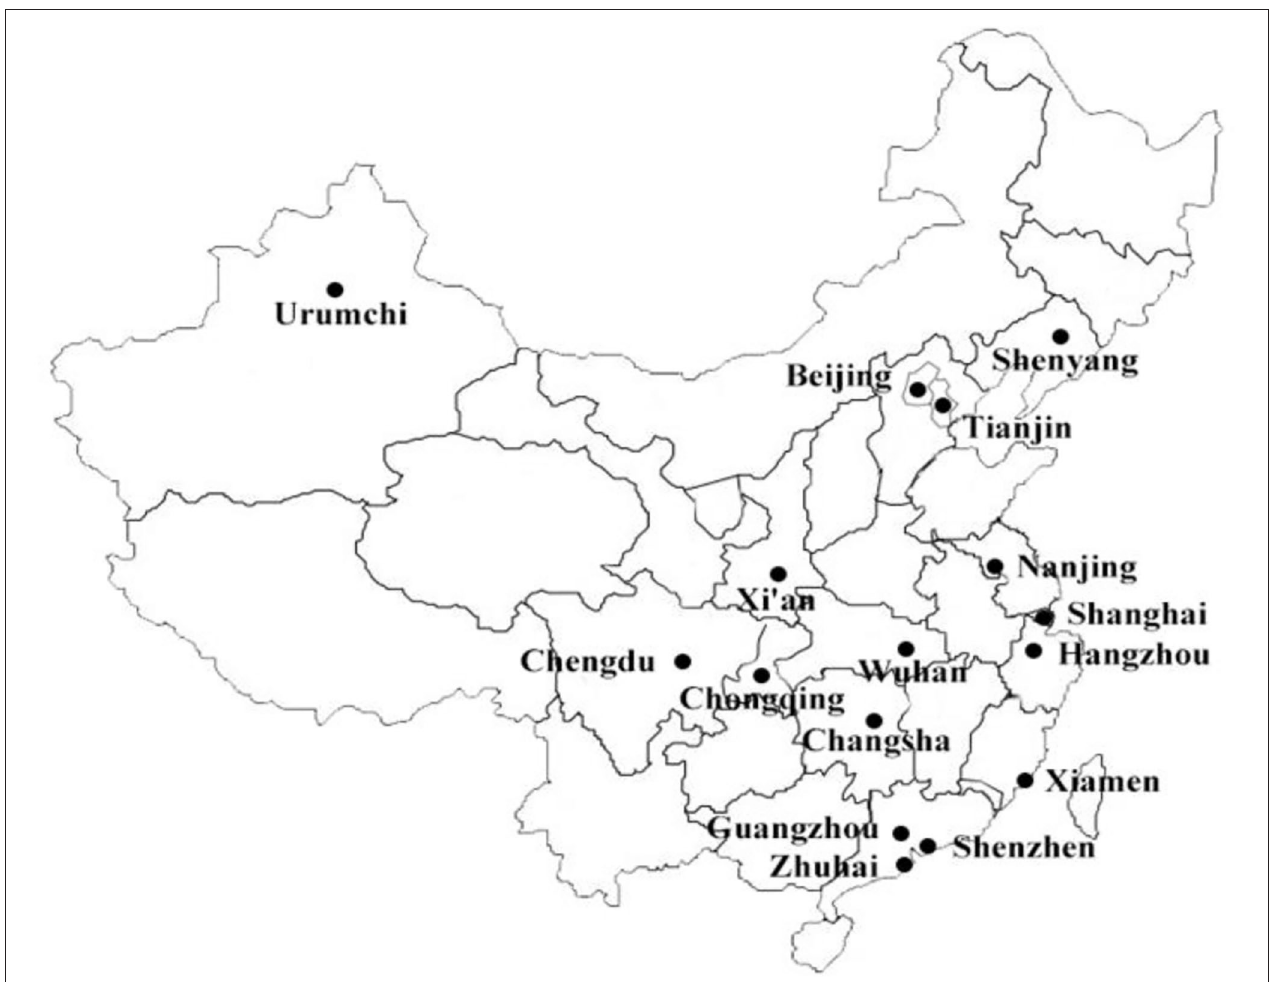
FIGURE 2 | The geographical position of 16 large and medium-sized